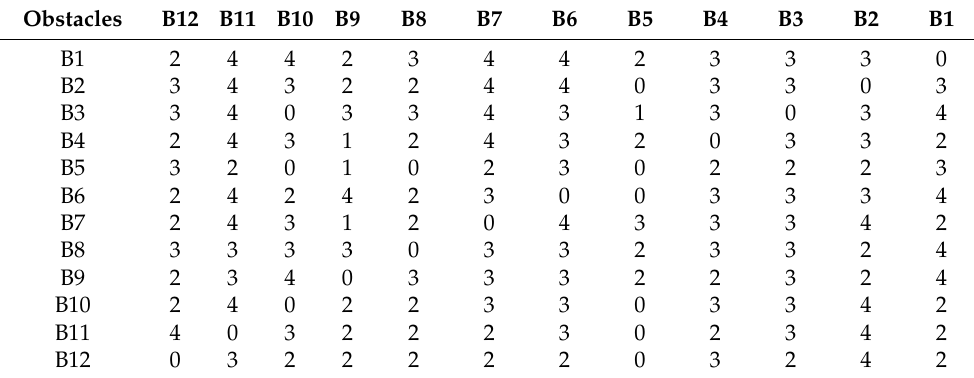
Table 11. Generating the direct-relation matrix